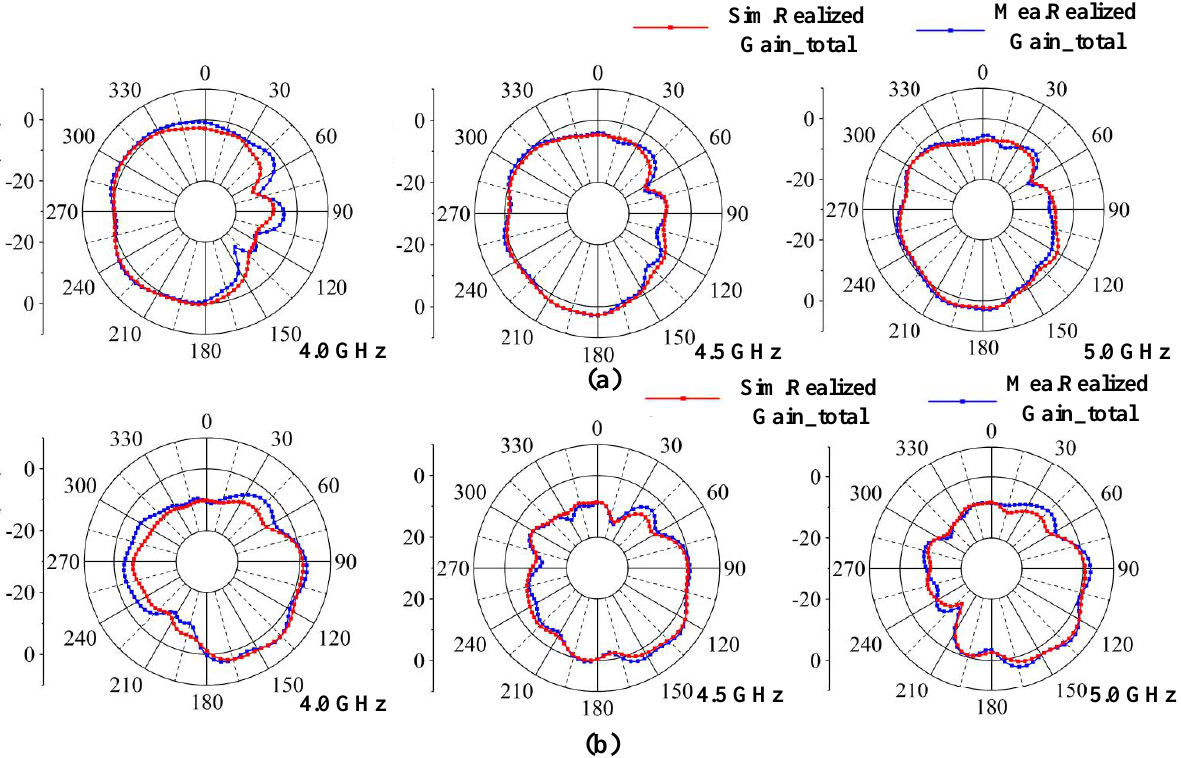
Figure 19. Simulated and measured radiation patterns of the proposed MIMO system in the 𝑥𝑜𝑦 plane. ( a ) Ant 1. ( b ) Ant 2.